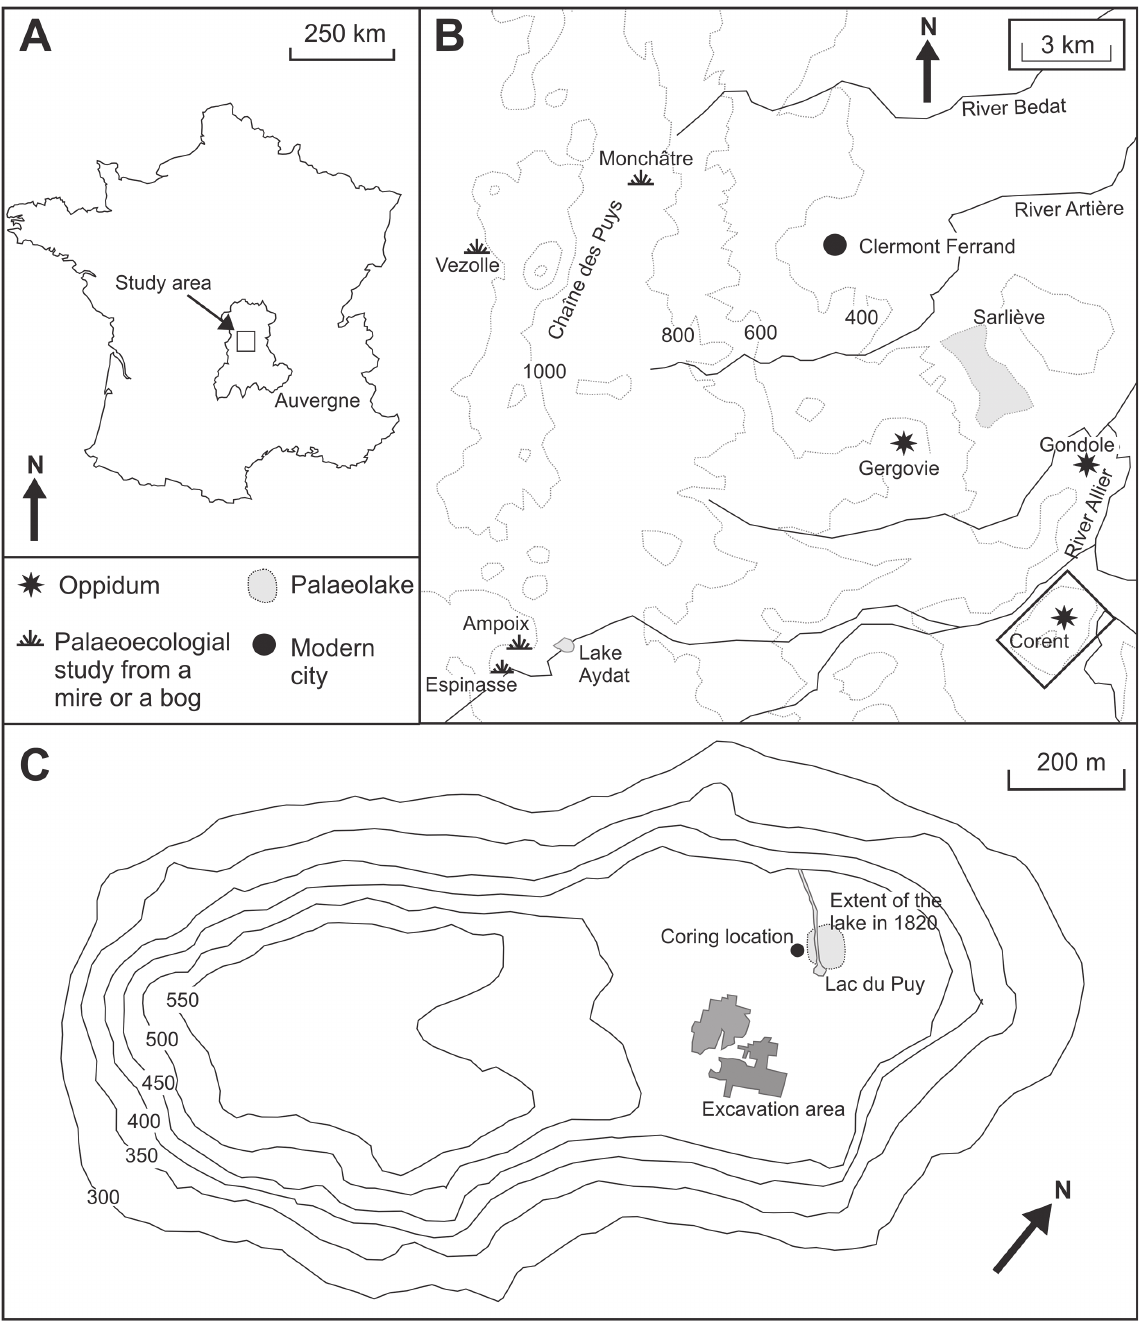
Fig 1. (A) Location of Auvergne and the study region within France; (B) Palaeoecological sites and Oppida surrounding Clermont-Ferrand; (C) The Plateau of